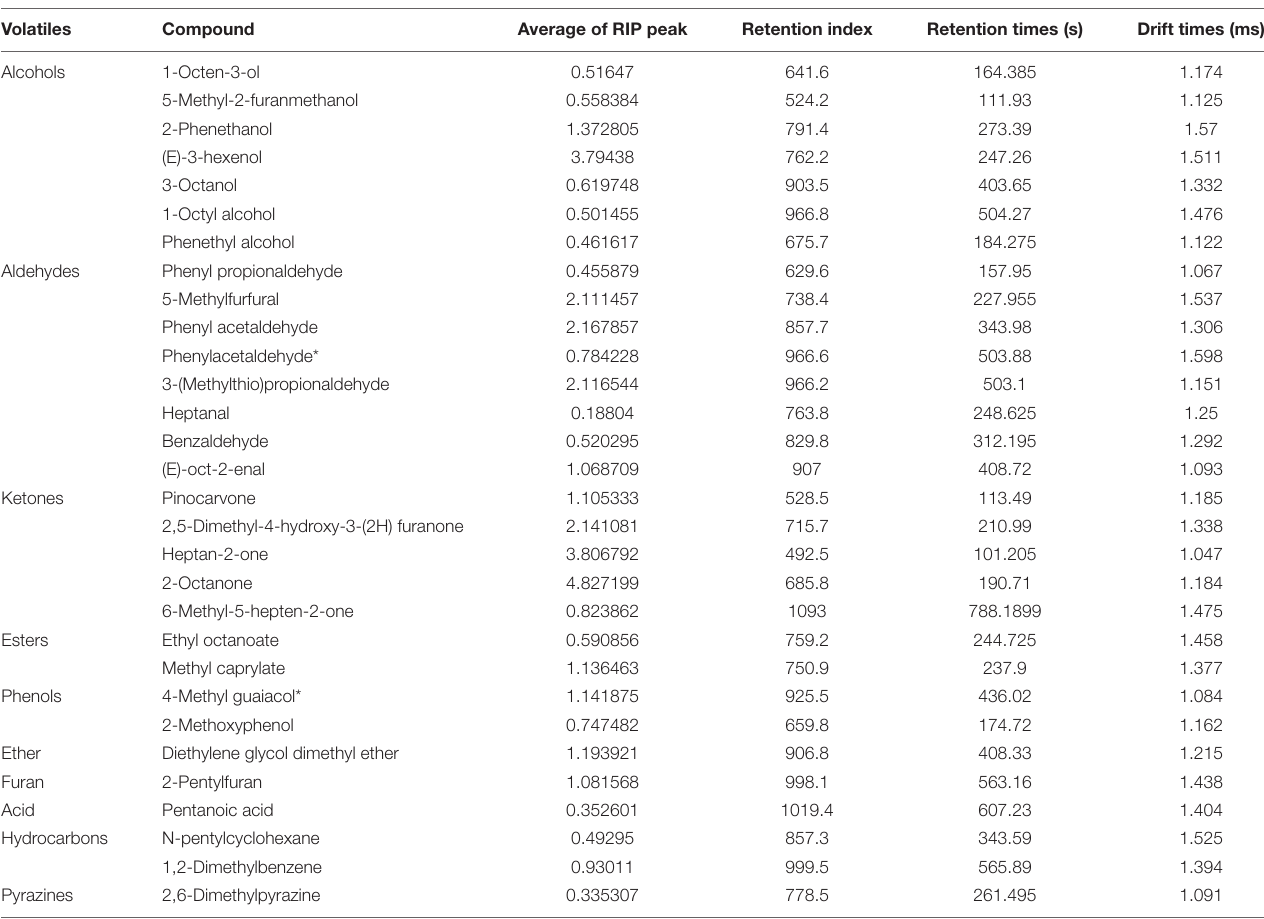
TABLE 2 | Volatile compounds tested in Dongxiang tribute mutton using